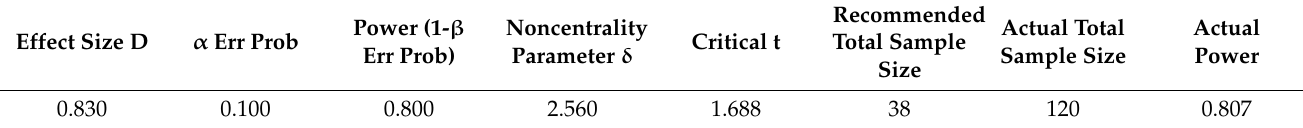
Table 7. Statistical power of independent sample t -tests sample size.